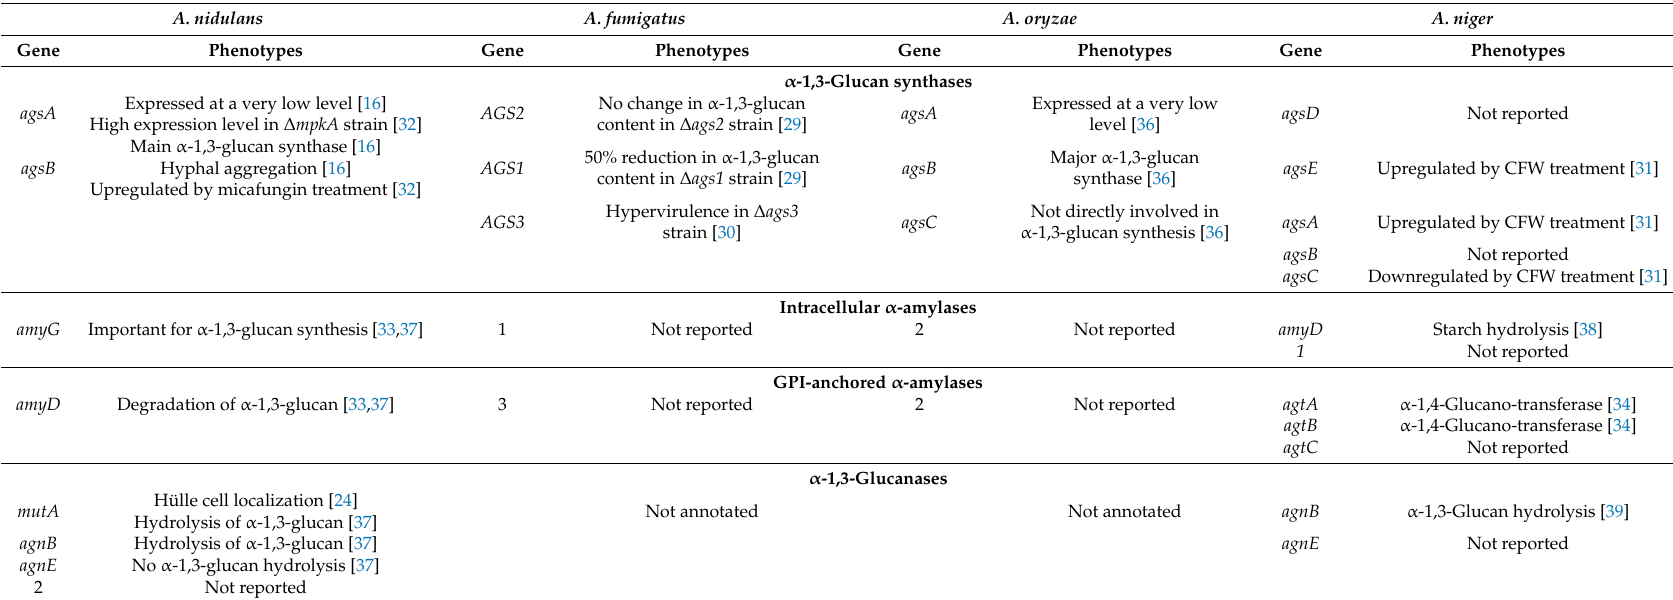
Table 1. Genes related to α -1,3-glucan synthesis and degradation in Aspergillus